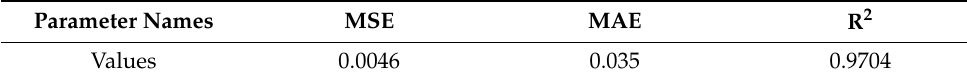
Table 2. Results of MSE, MAE and R 2 .